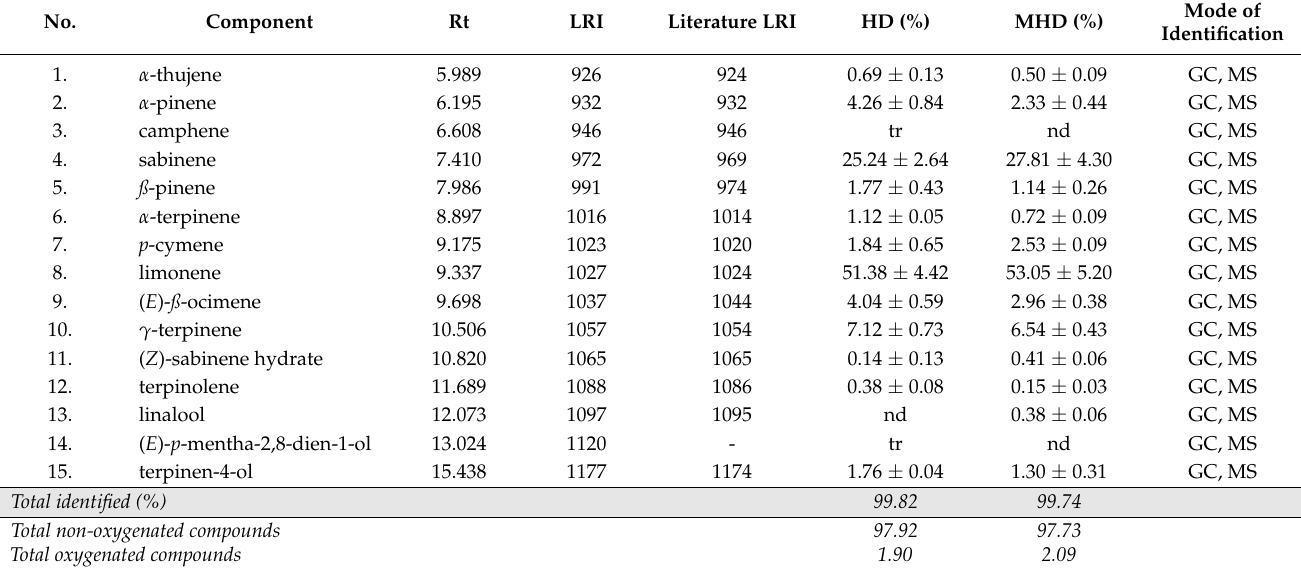
Table 1. Chemical composition of sea fennel essential oils isolated by hydro-distillation (HD) and microwave-assisted hydro-distillation (MHD), analysed by gas chromatography coupled with mass spectrometry